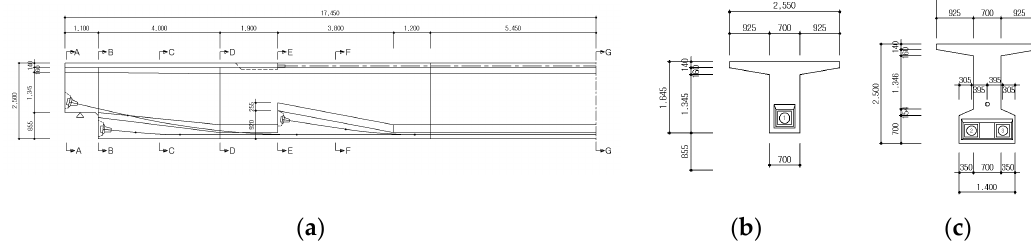
Figure 14. Shape of 35 m-long full-scale PSC I-girder specimen: ( a ) longitudinal view with 3 segments (12 + 10.9 + 12 m); ( b ) sectional view (A-A); and ( c ) sectional view (B-B);.